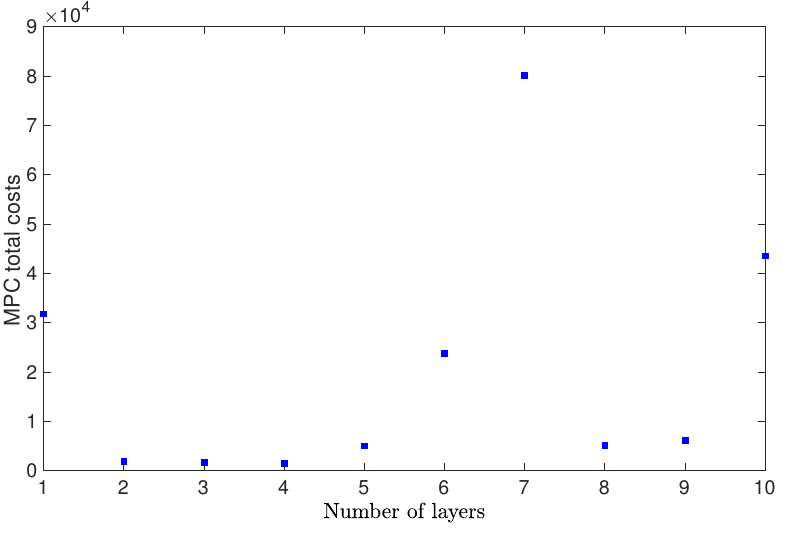
Figure 18. MPC total costs vs. RNN depth.